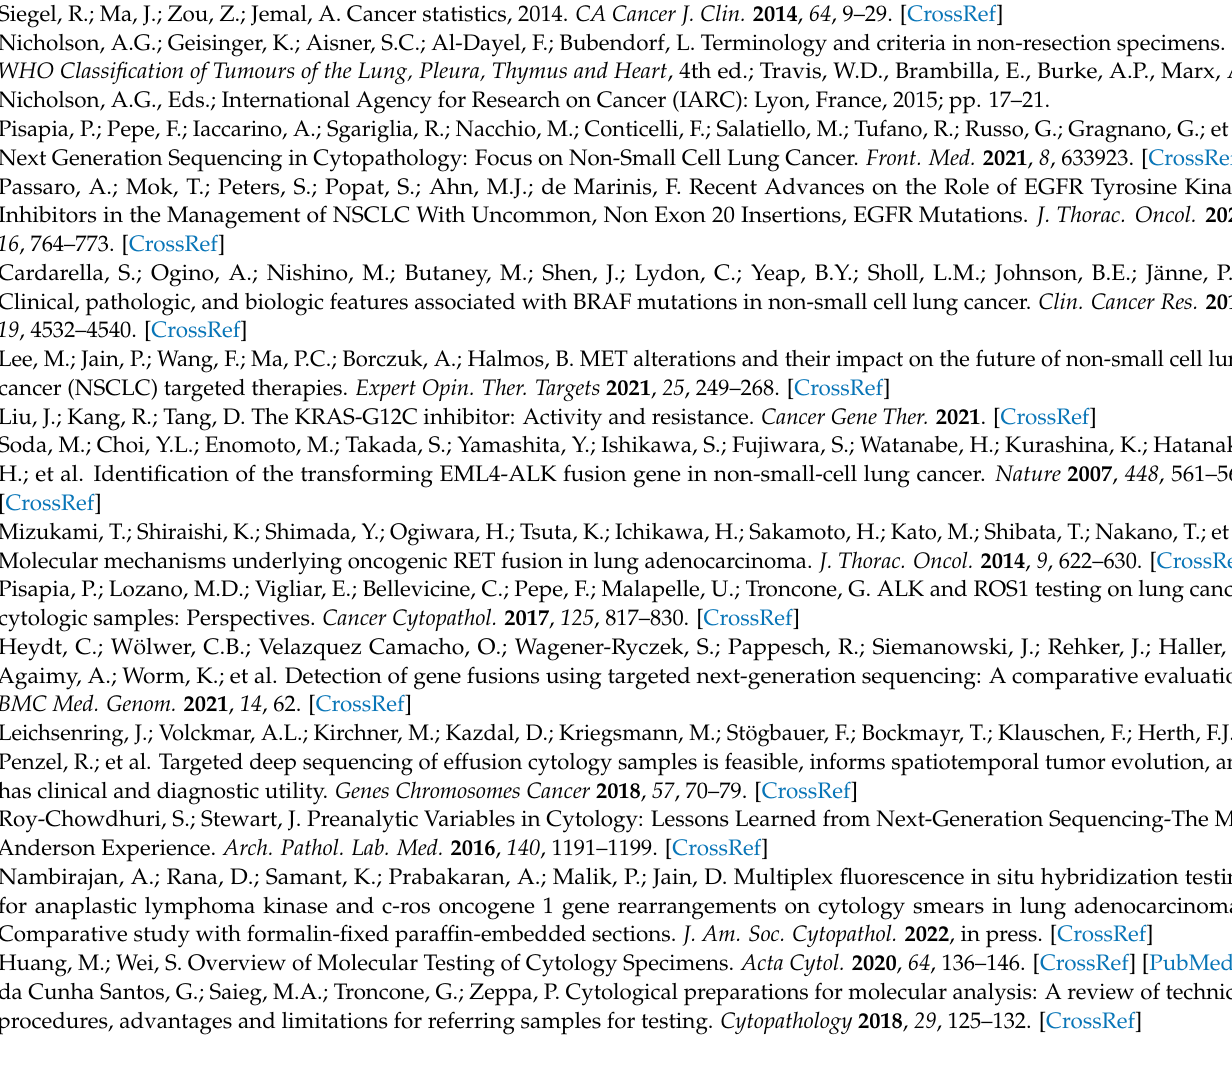
hybridization, Table S1: Primer Design Fast Track Analysis for KRAS Exon 2 and EGFR exons 19 and 21, Table S2: Parallel sequencing panel design, Table S3: Primer design for parallel sequencing of lung cancer; Table S4: FISH probes for ALK , MET , RET and ROS1